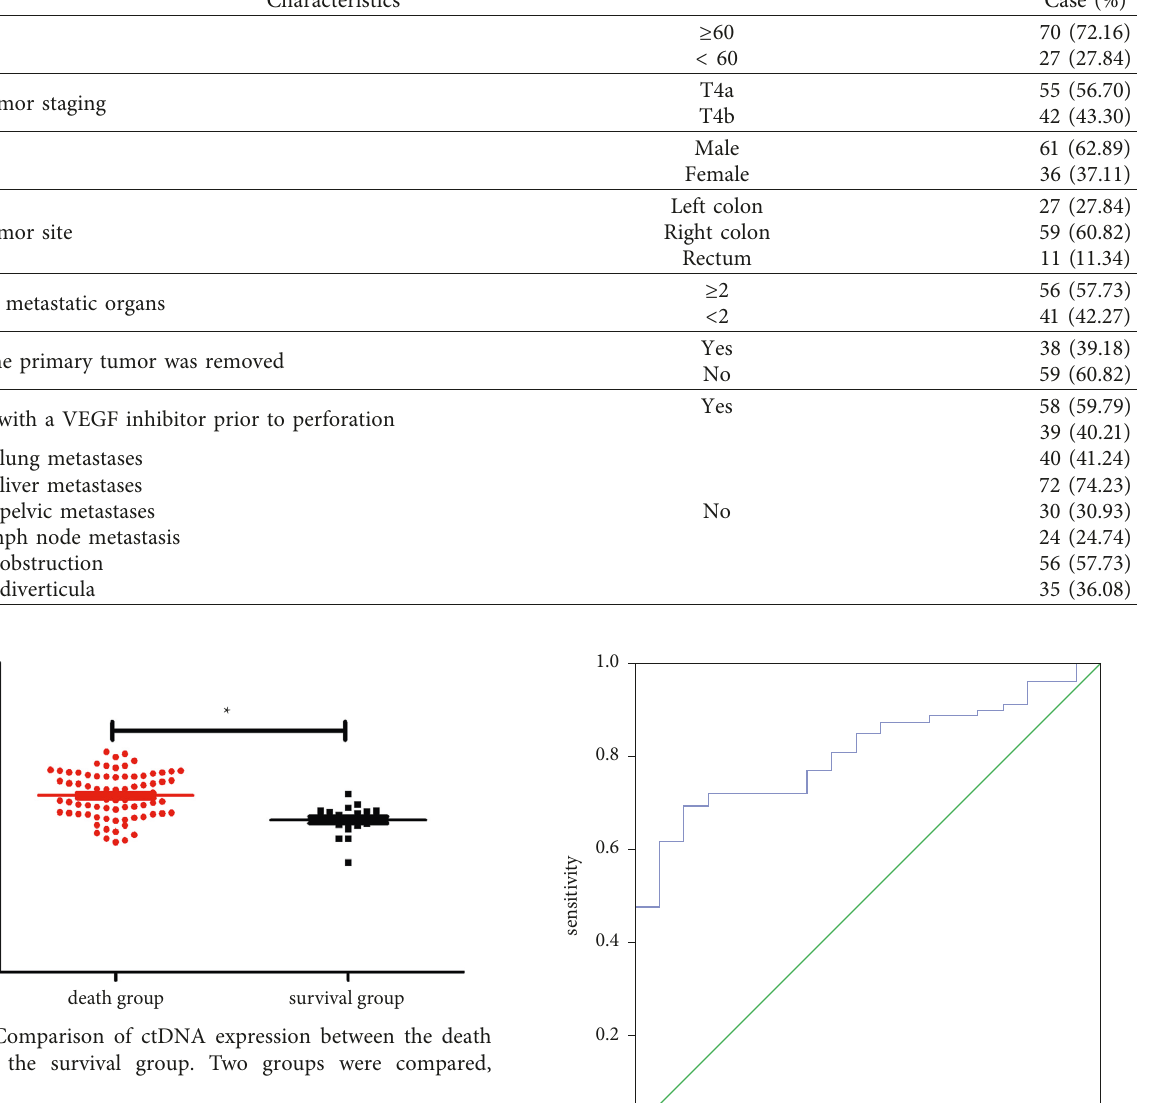
Table 1: Clinicopathological characteristics of patients with metastatic colorectal cancer complicated with gastrointestinal perforation. Characteristics